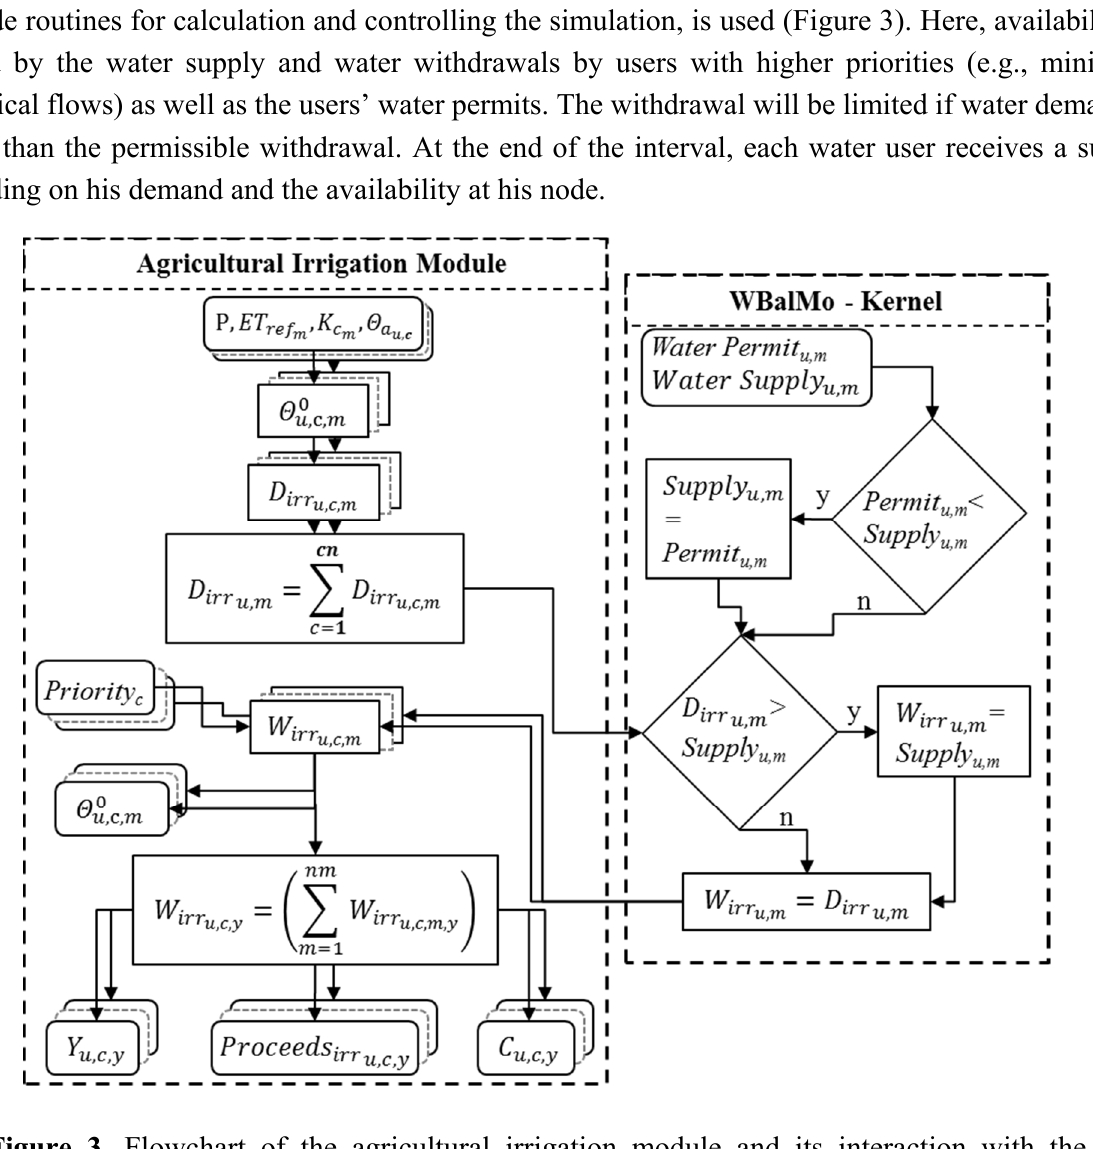
Figure 3. Flowchart of the agricultural irrigation module and its interaction with the WBalMo −